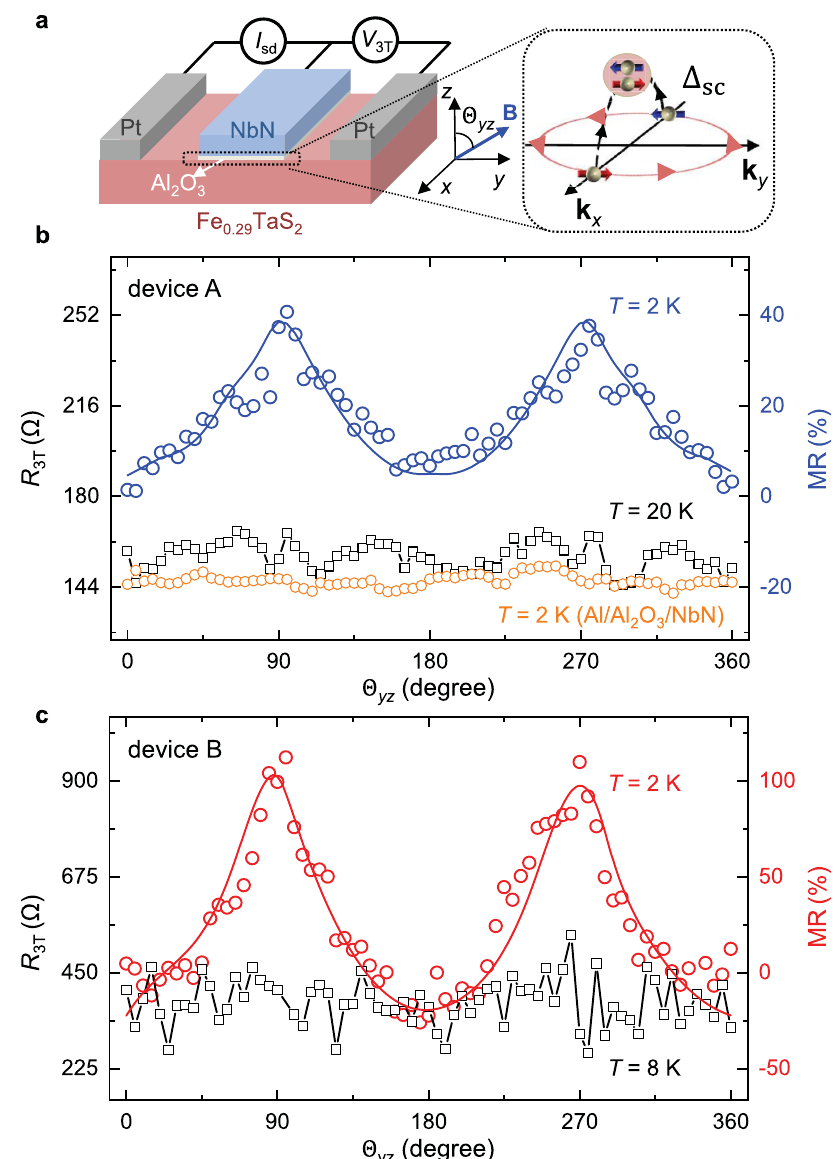
Fig. 2 Large magnetoresistance of the quasi-2D vdW Fe 0.29 TaS 2 /SC junction. a Illustration of the quasi-2D vdW Fe 0.29 TaS 2 /SC MR device and the measurement geometry. The right panel shows the schematic of the spin-triplet pairing component resulting from Rashba SOC at the FM/SC interface. b The interfacial resistance ( R 3T = V 3T / I sd ) and MR ratio as a function of the magnetic fi eld angle measured on the typical quasi-2D vdW Fe 0.29 TaS 2 /SC device (device A) under B = 9 T. The orange curve represents the resistance measured on a typical control device (Al/Al 2 O 3 /NbN) under B = 9 T. c The interfacial resistance and MR ratio as a function of the magnetic fi eld angle on device B under B = 9 T. The solid lines in b and c are guides to the